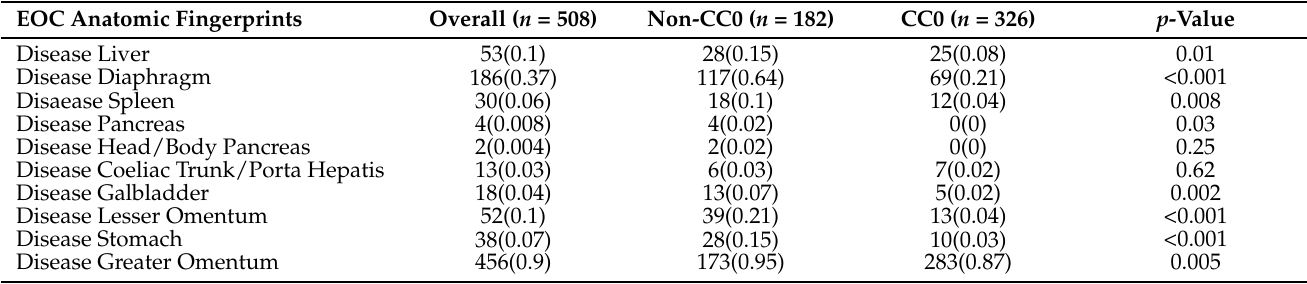
Table A1. The complete list of the EOC anatomic fingerprints for the whole dataset broken down by CC0/non-CC0 patients. Chi-Square Test of Independence was used for categorical data. Statistical analysis was performed using Python’s SciPy library. Values are mean ± SD or n